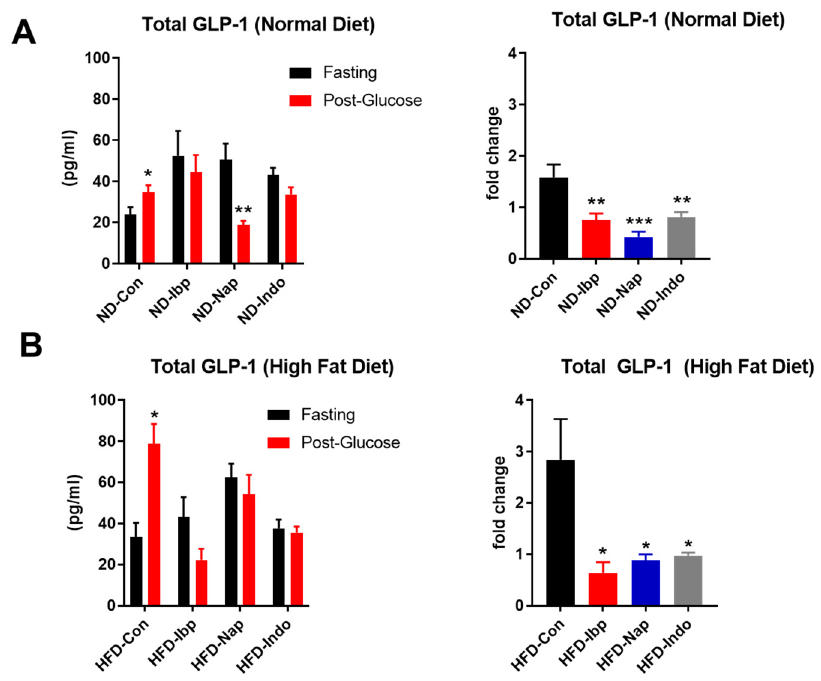
Figure 5. NSAIDs supplementation impairs glucose-stimulated GLP-1 secretion. Serum levels of total GLP-1 expressed in (pg/mL) during fasting (Black bars) and 5 min post-glucose gavage (Red bars) and Fold change in GLP-1 after glucose challenge in C57 Blc/6J male mice placed on either ( A ) a normal chow diet (ND) or ( B ) a high-fat diet (HFD) and treated with PBS (Con), ibuprofen (Ibp), naproxen, (Nap), or indomethacin (Indo) for 4 weeks; n = 6 (Con), 4 (Ibp), 6 (Nap), and 5 (Indo). All results are presented as mean ± SEM (error bars) ( n = 4–8). Student’s t test was used to detect differences in GLP_1 levels between fasting and post-glucose gavage states. One-way ANOVA was used to detect differences between control and the three NSAID groups. Statistical significances are denoted with asterisks as follows: *, p ≤ 0.05; **, p ≤ 0.01; ***, p ≤ 0.001.